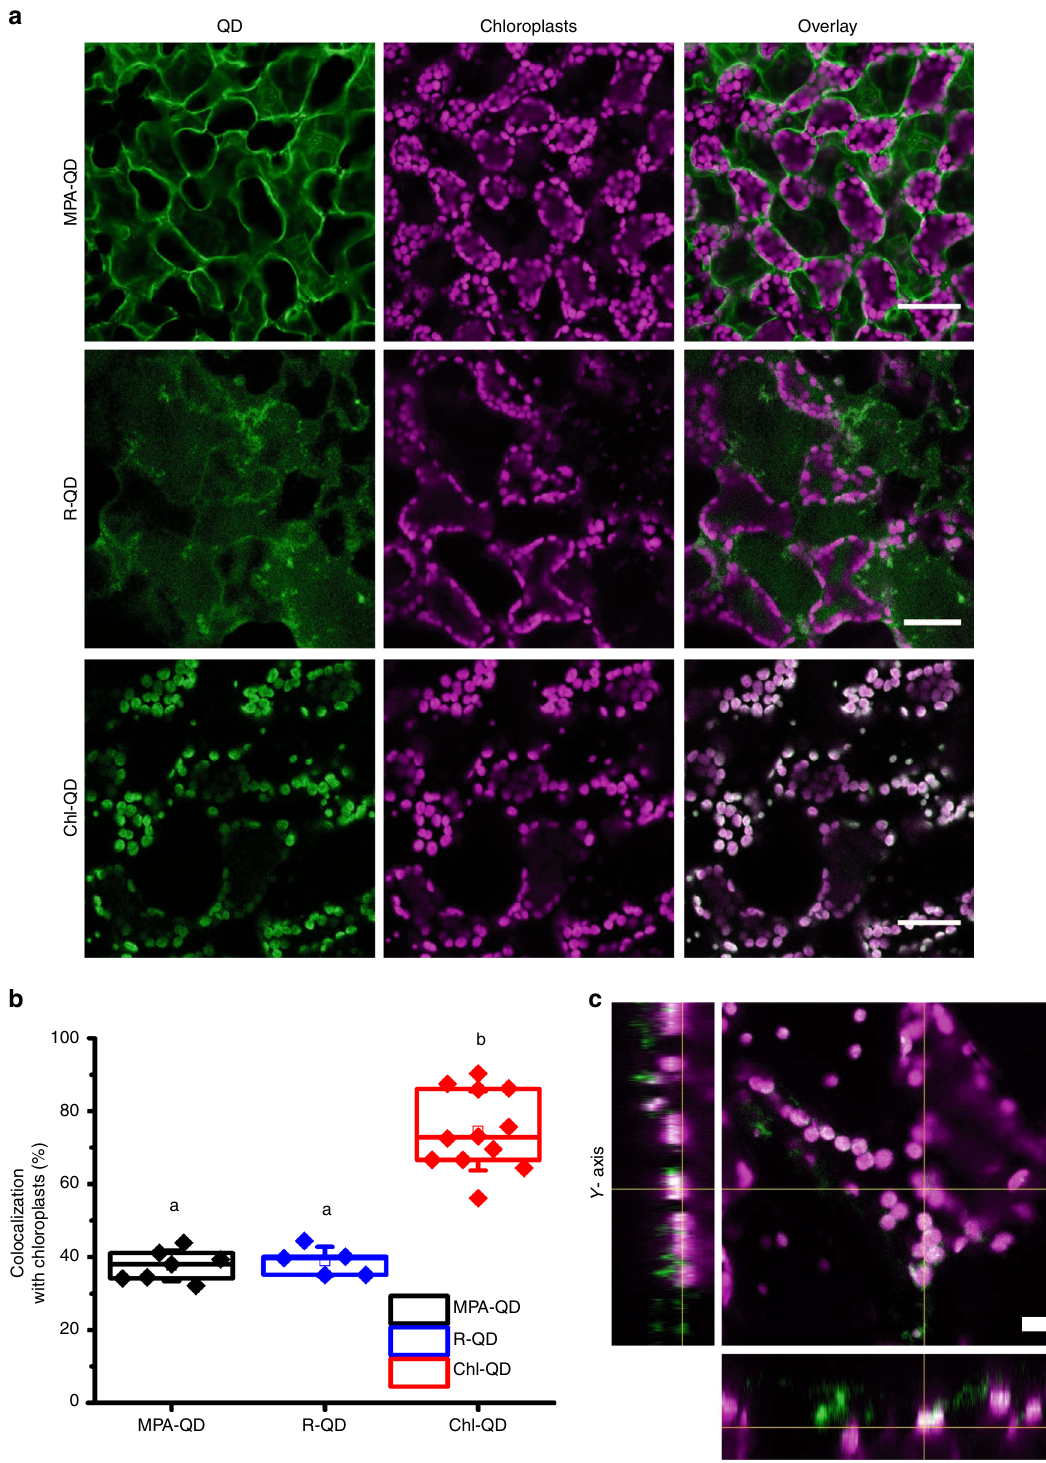
Fig. 3 Targeted delivery of quantum dots to chloroplasts of Arabidopsis leaf mesophyll cells. a Confocal microscopy images of chloroplasts in leaf mesophyll cells indicating a higher degree of colocalization of QD coated with guiding peptide (Chl-QD, n = 12) with chloroplasts compared to QD without targeting peptide (MPA-QD, n = 7) and QD coated with a randomized amino acid sequence of the guiding peptide (R-QD, n = 5). Scale bar, 40 µ m. b Colocalization rates of Chl-QD ( n = 12) with chloroplasts compared to MPA-QD ( n = 7) and R-QD ( n = 5). Statistical comparisons were performed by one-way ANOVA based on Duncan ’ s multiple range test (two tailed). Lower case letters represent signi fi cance at P < 0.05. Box plot error bars represent standard deviation, boxes are the interquartile range from the fi rst to the third quartile with squares as the medians, and horizontal line represents the mean. c Orthogonal views of different planes from confocal images (z-stack) of Chl-QD colocalization within chloroplasts. Scale bar, 10 µ